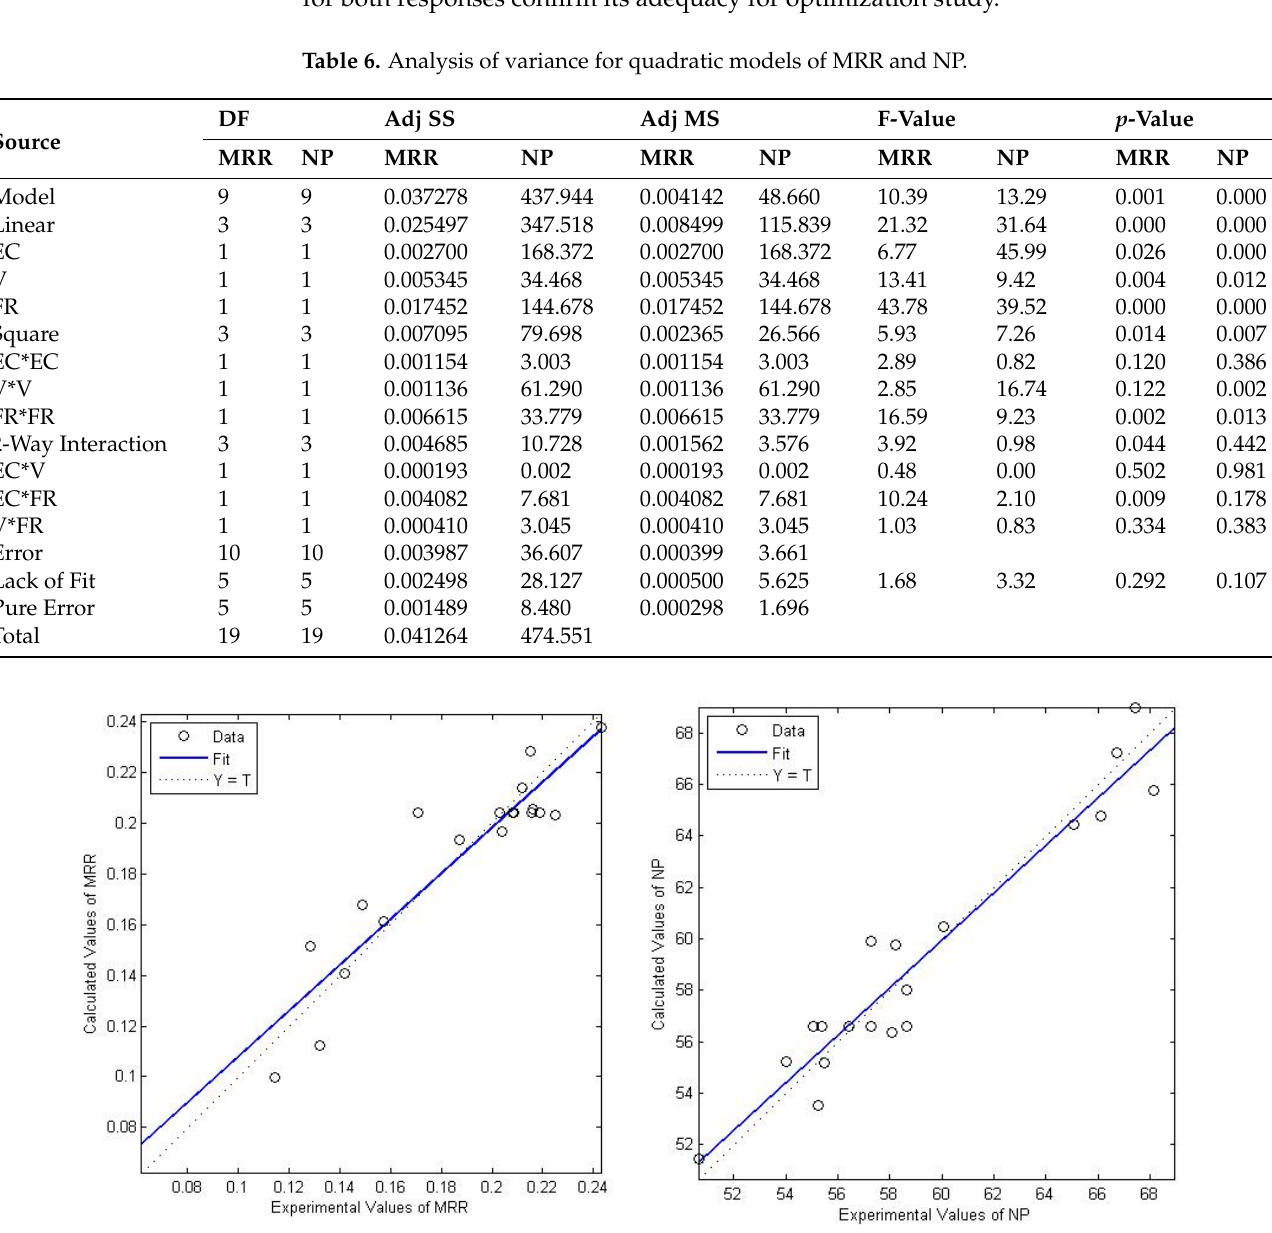
Figure 7. Normal probability plots for MRR and NP.